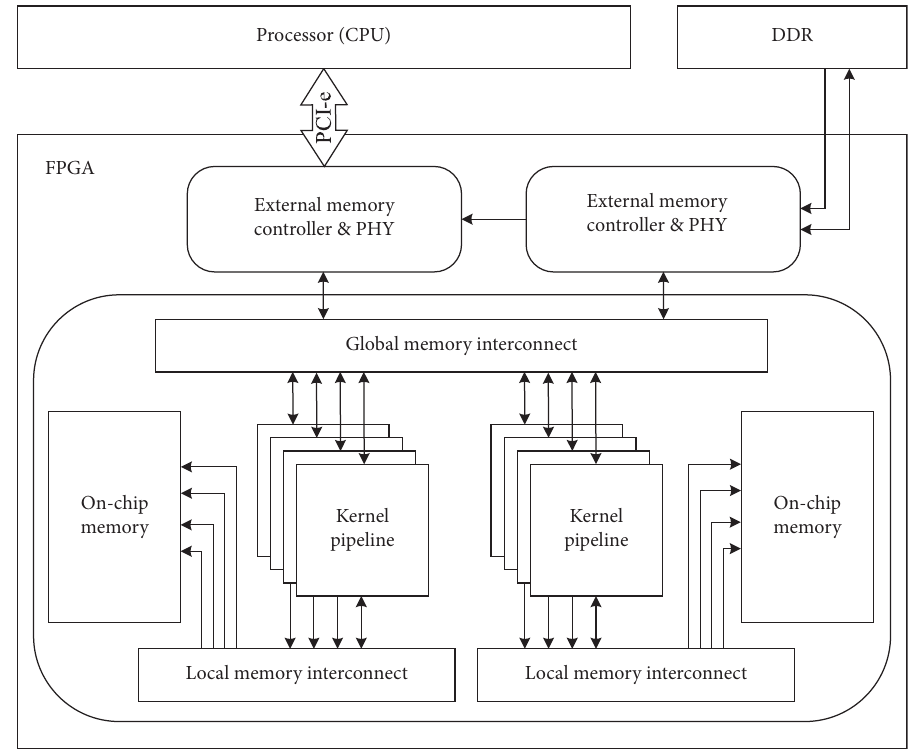
Figure 1: Architecture of heterogeneous platform with CPU and